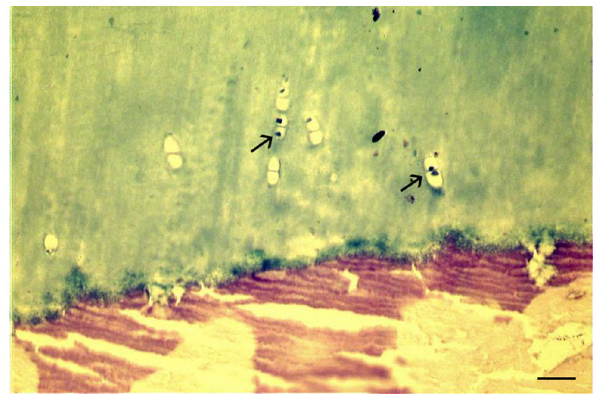
Figure 6. Histology of bone and cartilage. Undecalcified section through the cartilage (upper half) –bone (lower half) transition zone of the patella. Note the excellently well preserved cartilage and bone matrix and residues of nuclear material in some of the chondrocytes (arrows). (Giemsa-May-Gru¨nwald staining, undecalcified section, poly- acryl embedding, bar 150 m m).